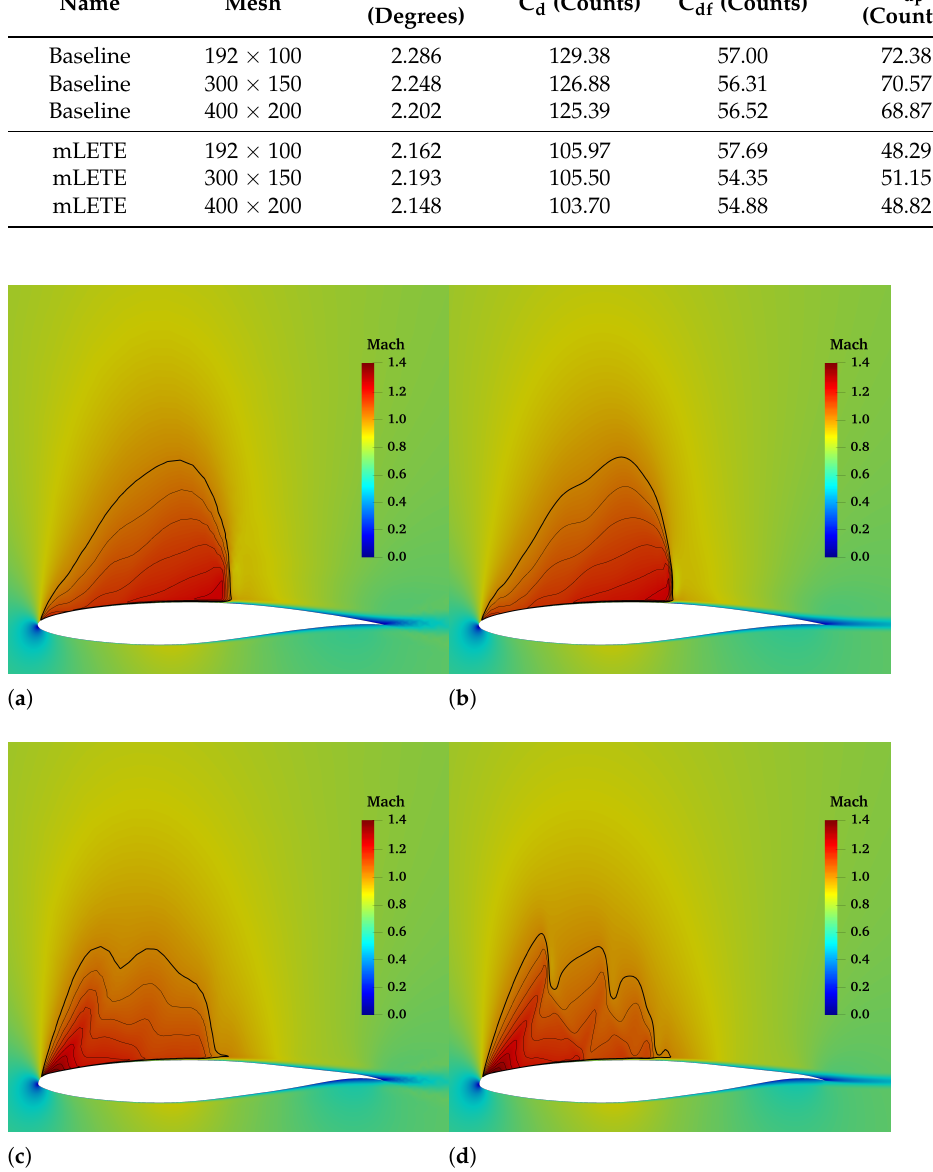
Figure 13. Flow structure with original mesh (192 × 100) and finer mesh (400 × 200). ( a ) Baseline mesh 192 × 100. ( b ) Baseline mesh 400 × 200. ( c ) mLETE mesh 192 × 100. ( d ) mLETE mesh 400 ×